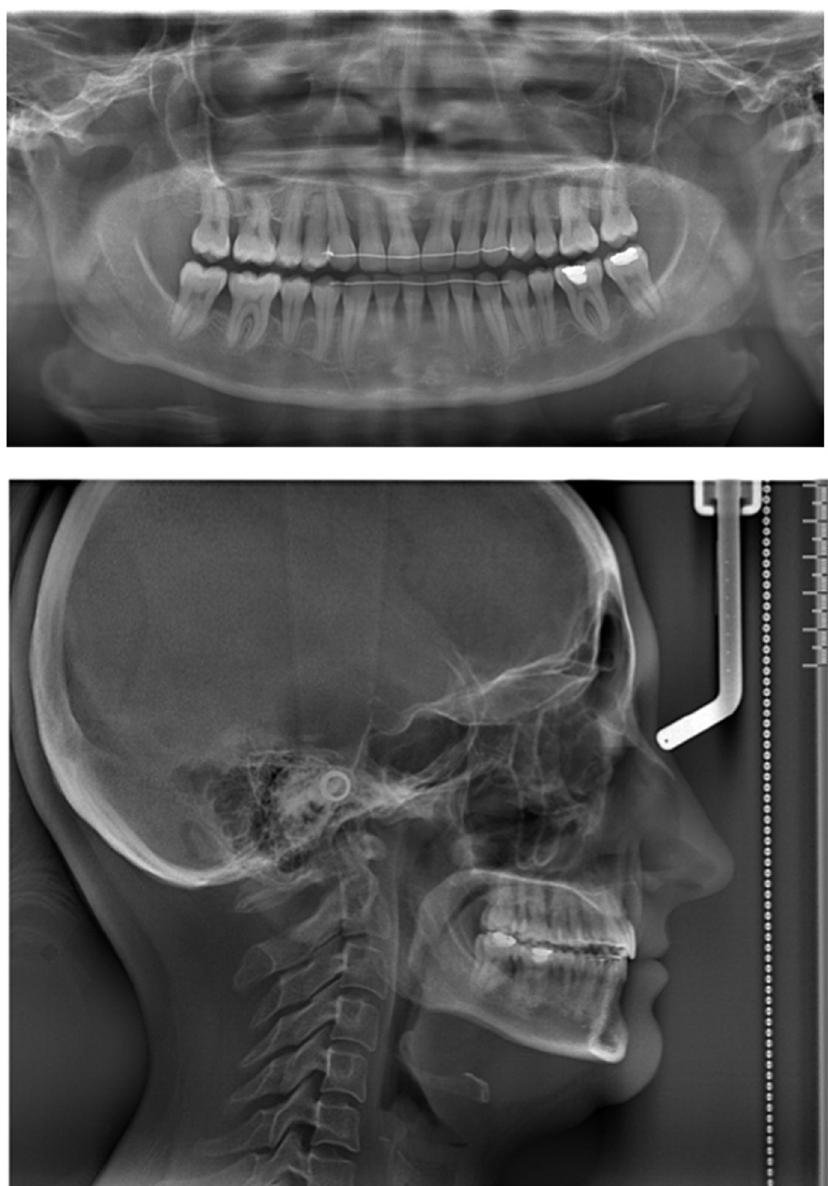
Figure 7. Posttreatment panoramic X-ray and lateral